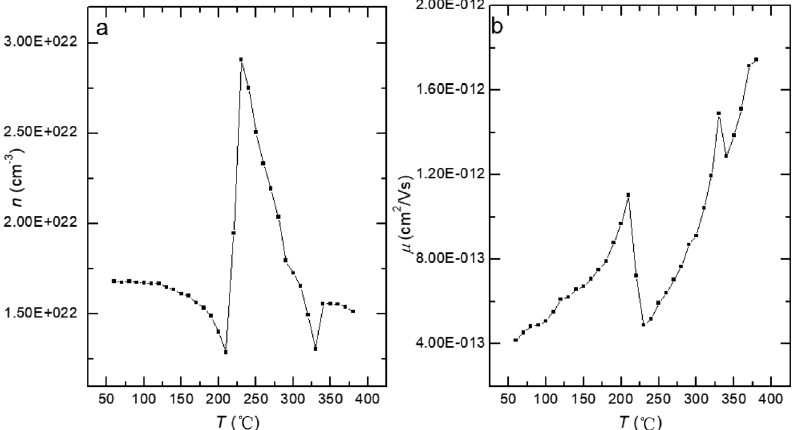
Fig. 9 Temperature dependence of (a) n and (b) μ in NBT